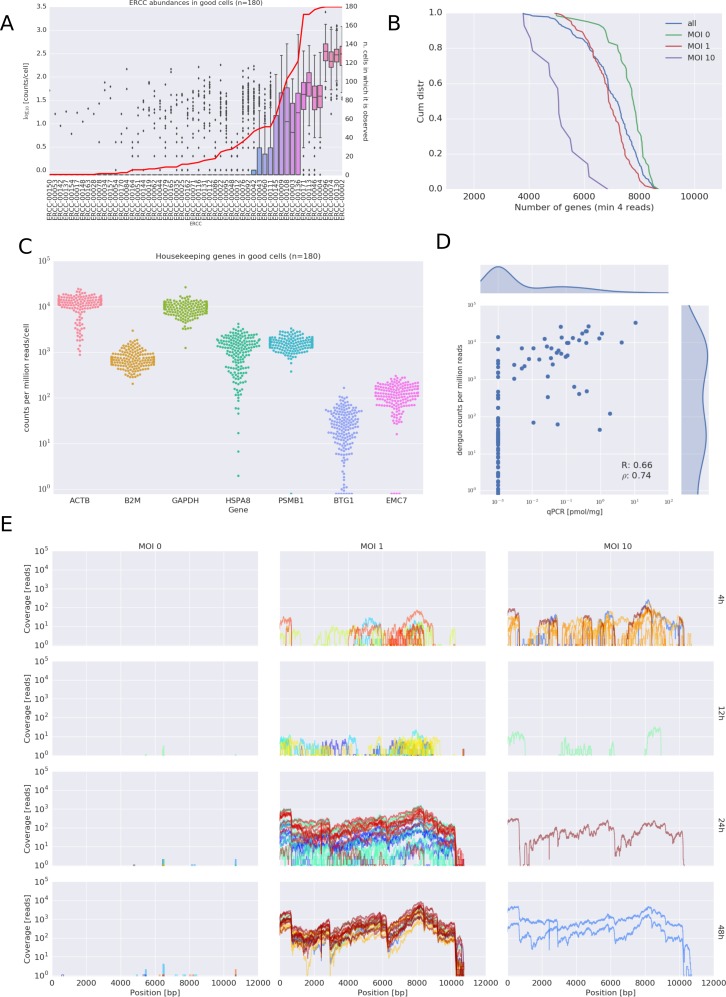
Quality Controls of the viscRNA-Seq approach.. (A) ERCC spike-ins abundance distributions in single cells. (B) Number of genes detected above four reads in the sequenced cells. (C) Expression of some housekeeping genes. (D) comparison of qPCR and sequencing for vRNA content. (E) Coverage of the dengue genome for all experimental conditions during the DENV infection.